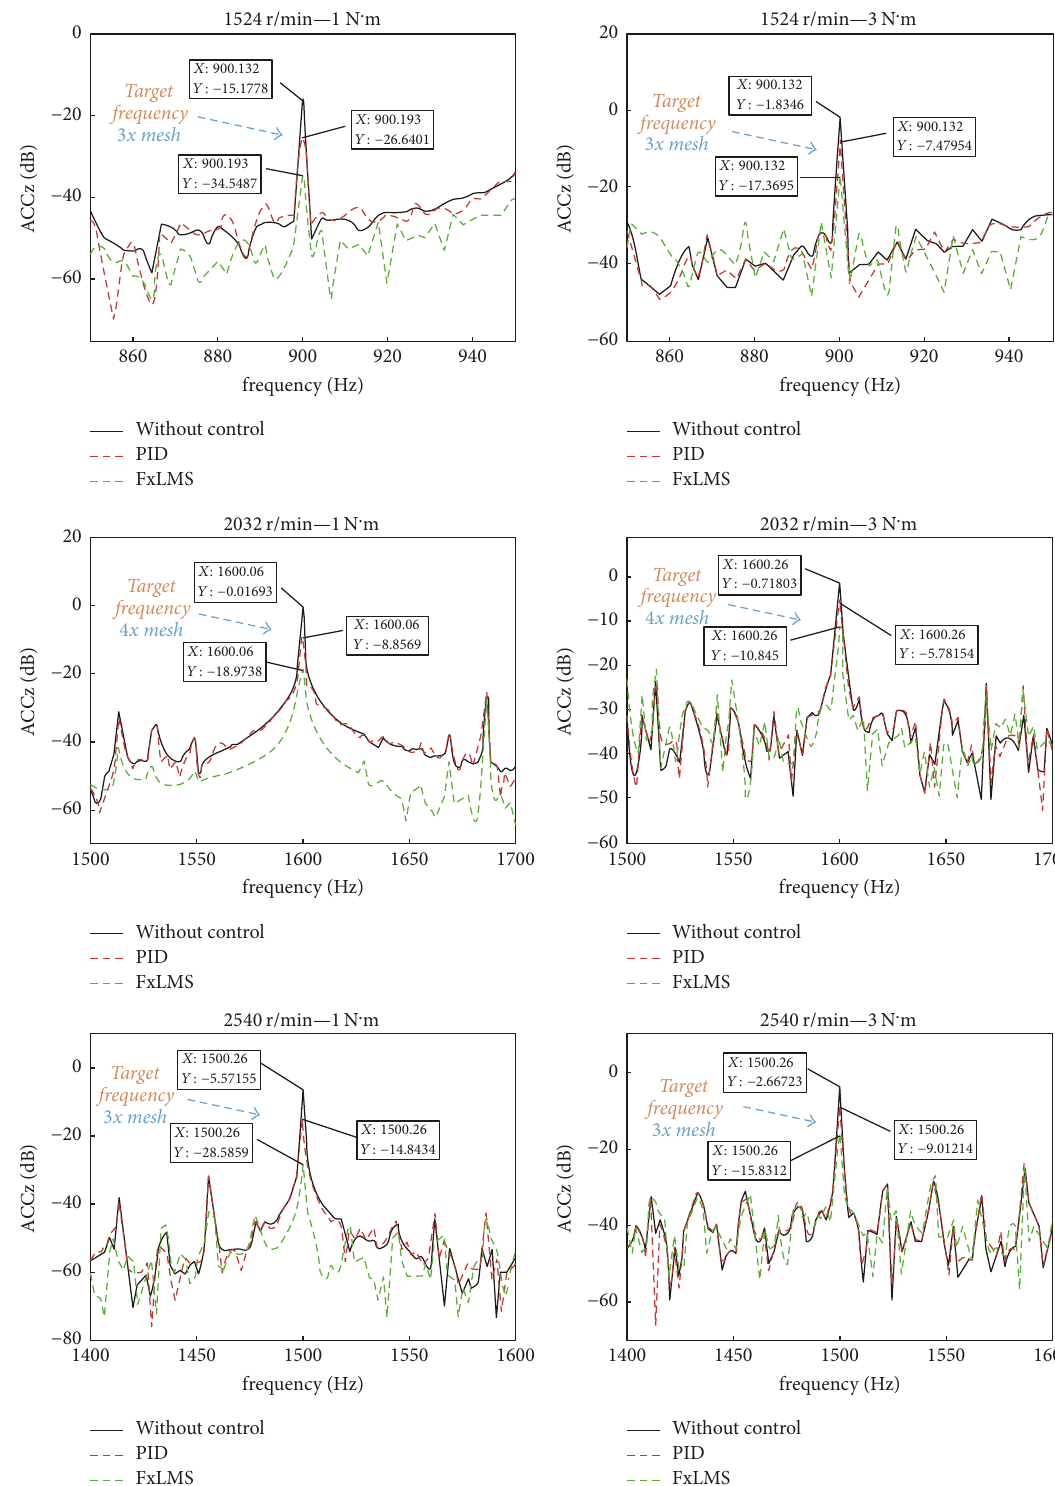
Figure 11: The vibration control results of the output shaft at the gear rotation